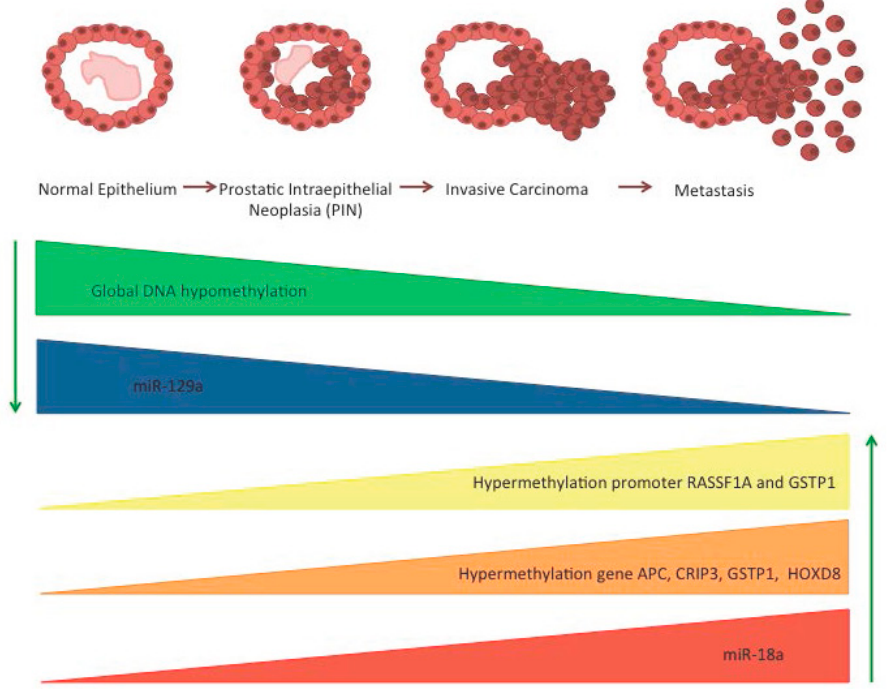
Figure 1. Potential epigenetic biomarkers in patients on AS. The figure shows the epigenetic modifications that have been tested as biomarkers. Green arrows represent down- and up-regulation of epigenetic biomarkers. The aberrant epigenetic changes have been described and cited in the